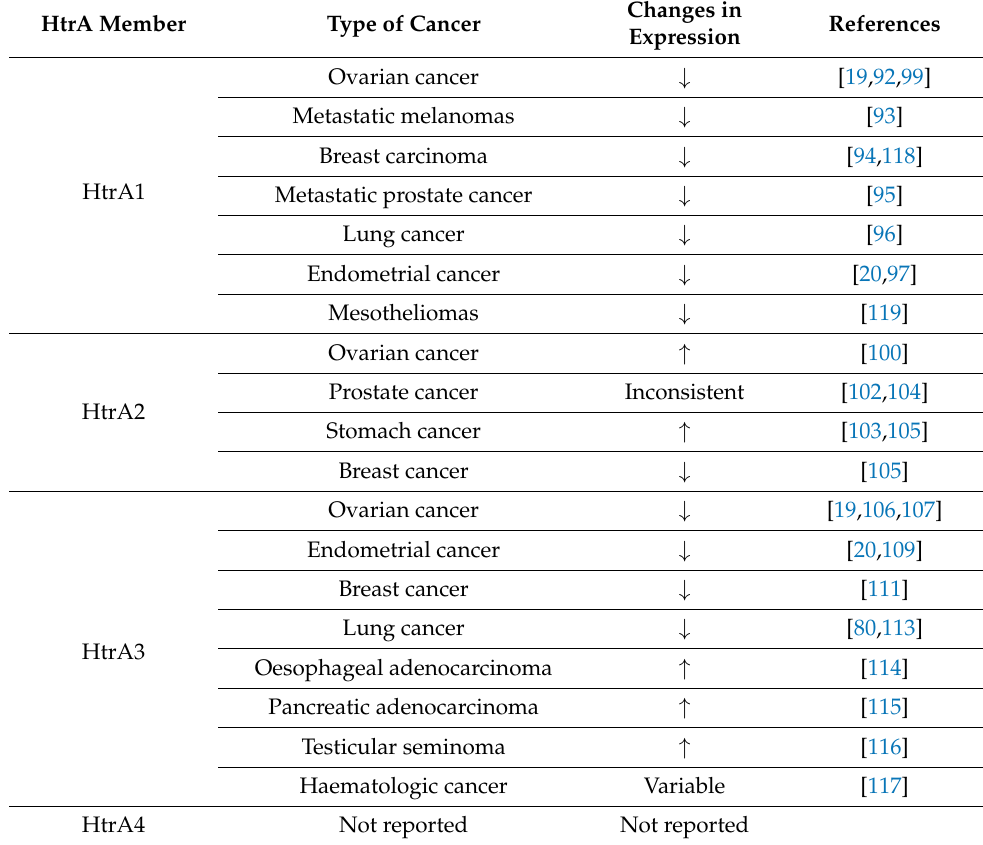
Table 5. Regulation of human HtrAs reported in primary studies of